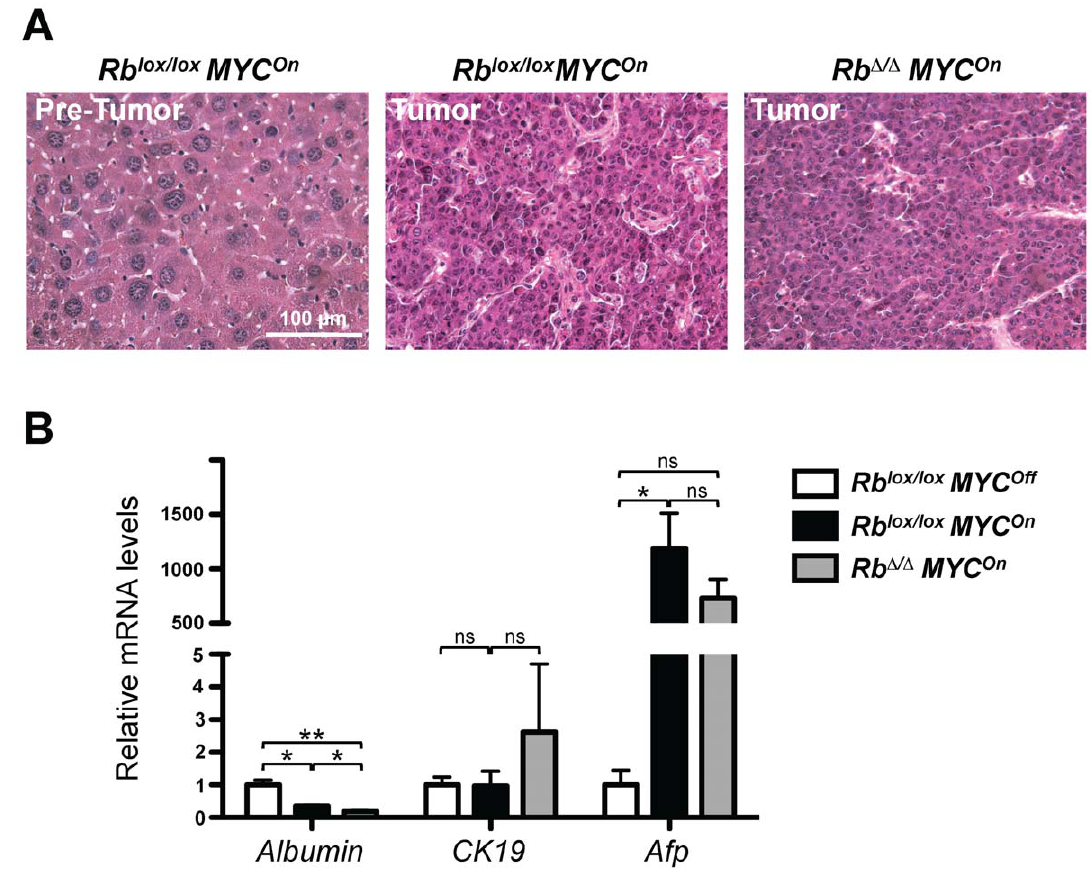
Figure 2. Rb inactivation does not change the histology and differentiation status of MYC-induced HCC. A. Histology of non-tumor liver tissue from MYC mutant mice (left) and tumor tissue from MYC (center) and MYC/Rb (right) mutant mice. B. RT-qPCR analysis of Albumin (a marker of hepatocytes), CK19 (a marker of bile ducts), and Afp (a marker of HCC) in control livers (white, n=2), MYC mutant tumors (black, n=3), and MYC/Rb mutant tumors (grey, n=3). Note that the p-value for Afp between control livers and MYC/Rb mutant tumors is 0.06, just below the significance threshold.